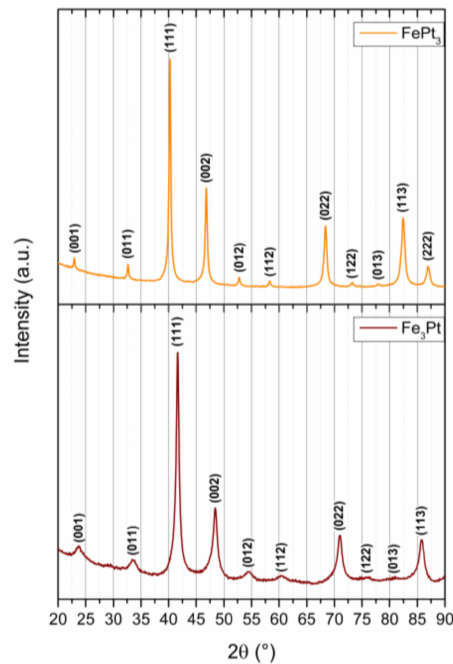
Figure 8. Diffraction patterns of the prepared FePt 3 and Fe 3 Pt particles obtained by the BnOH route and annealed at 800 ◦ C for 2 h.